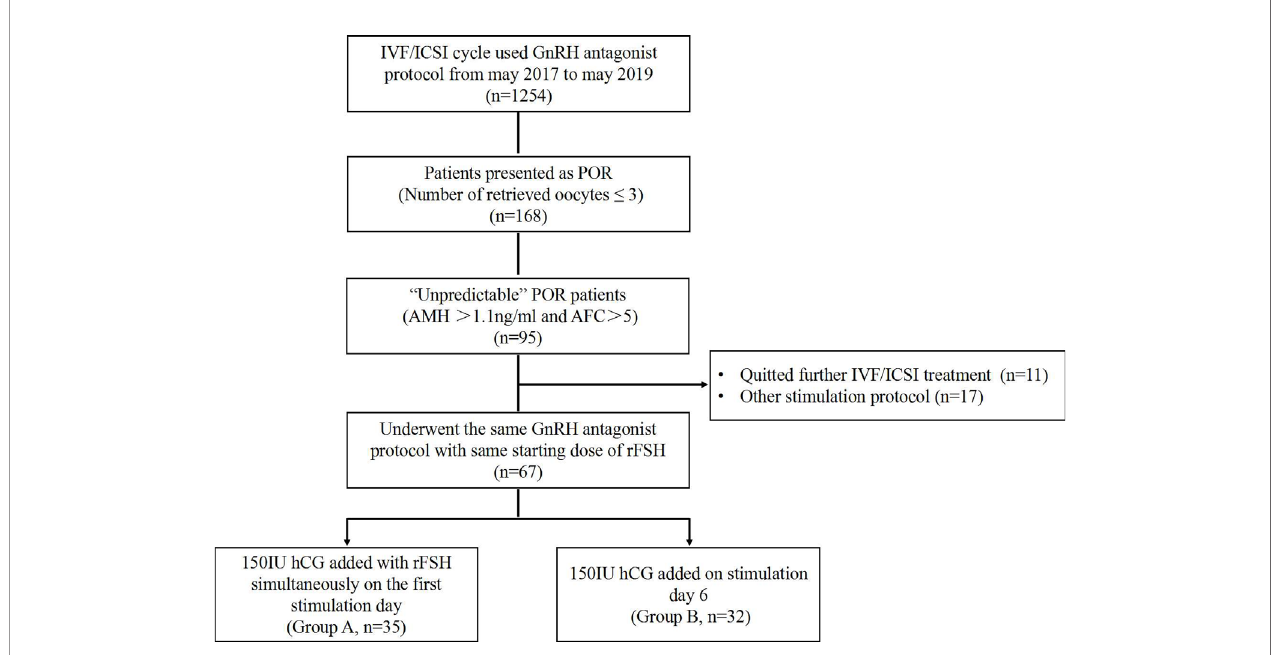
FIGURE 1 | Patient inclusion fl ow